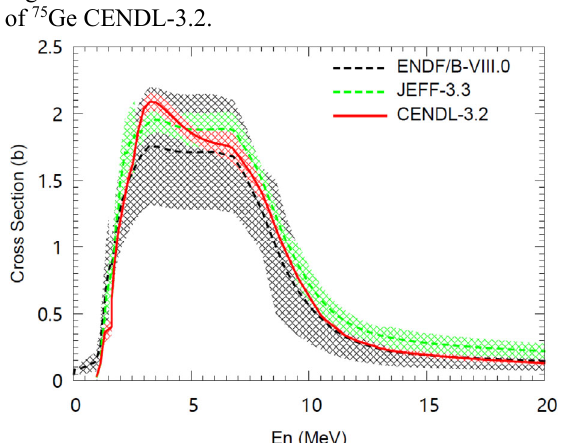
Fig.7. The comparison of evaluated 95 Zr(n,inl) cross sections and uncertainties in ENDF/B-VIII.0, JEFF-3.3 and CENDL-3.2.